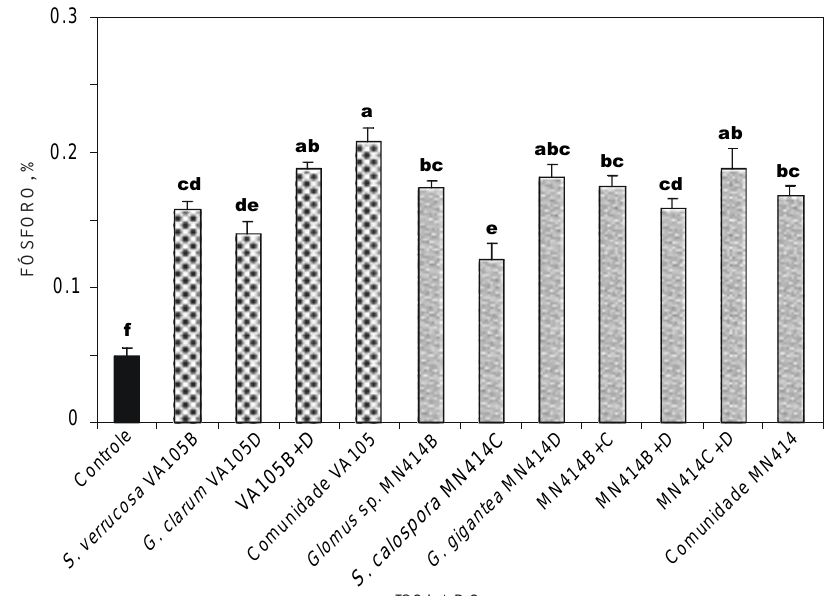
Figura 4. Conteúdo de fósforo na parte aérea de plantas trevo vermelho inoculadas com FMA isolados ou em combinações. Colunas representam a média de cinco repetições e barras representam o erro-